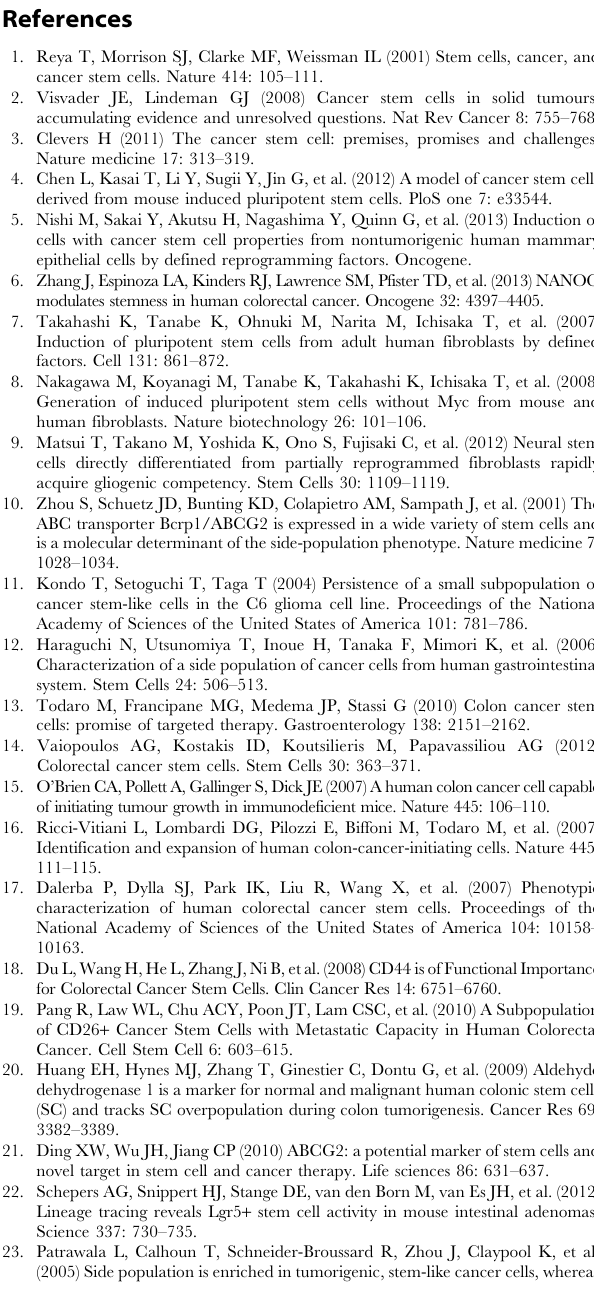
Table S1 Primer sequences used in qRT-PCR. (PDF) Table S2 Summary of tumor formation derived from trans- duced DLD-1